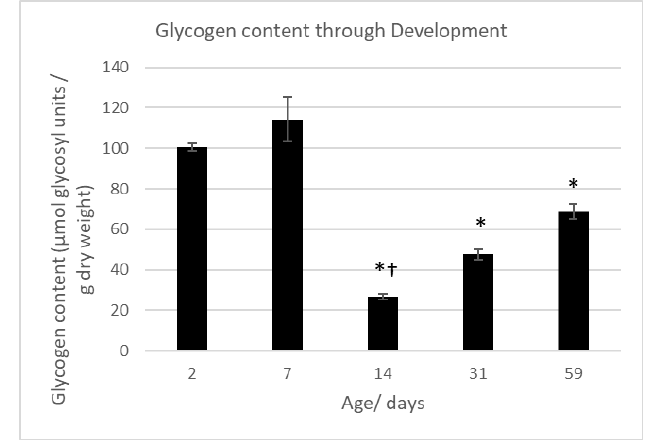
Figure 8. Glycogen levels in hearts during development. Data analysed by 1-way ANOVA with Bonferroni’s post-hoc test. * = p < 0.05 vs. both 2 days of age and 7 days of age. † = p < 0.001 vs. adult hearts. Data points represent mean ± standard error.